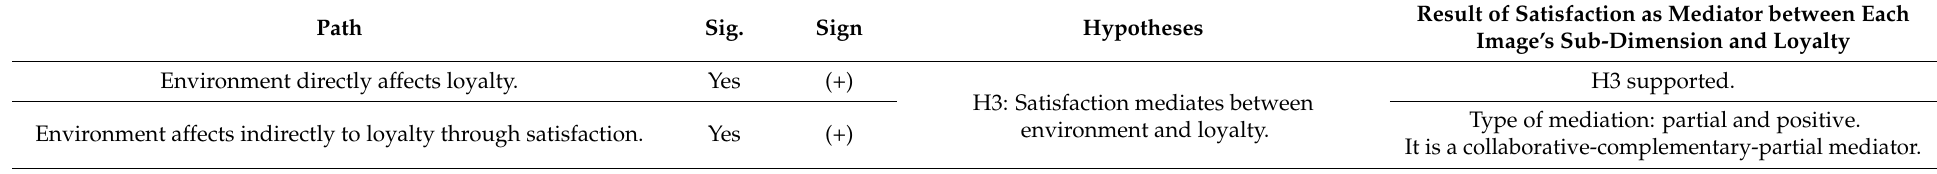
Table 8. Mediation analysis of